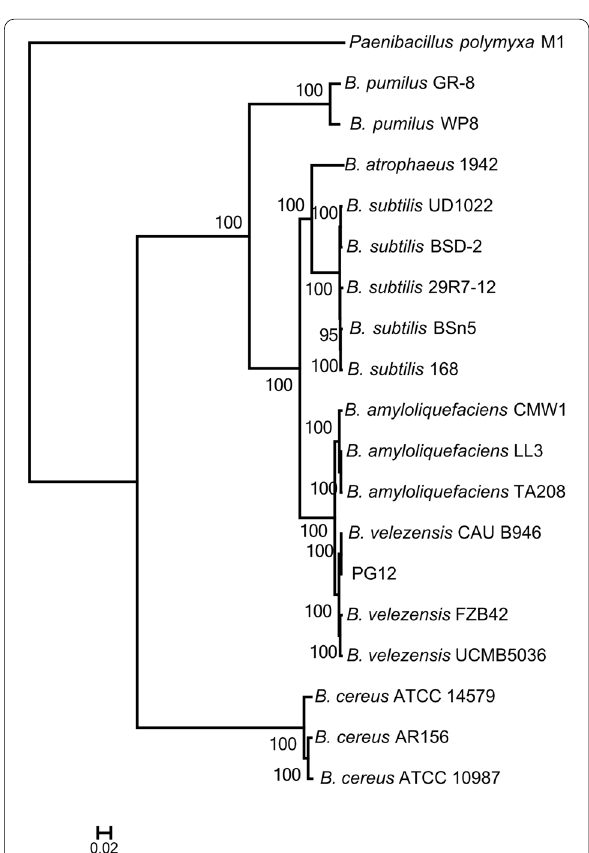
Fig. 1 Phylogenetic tree showing the relationship of PG12 with other Bacillus strains. The tree was constructed according to the concatenated alignments of 624 single core genes using MEGA 5, with Paenibacillus polymyxa M1 as an